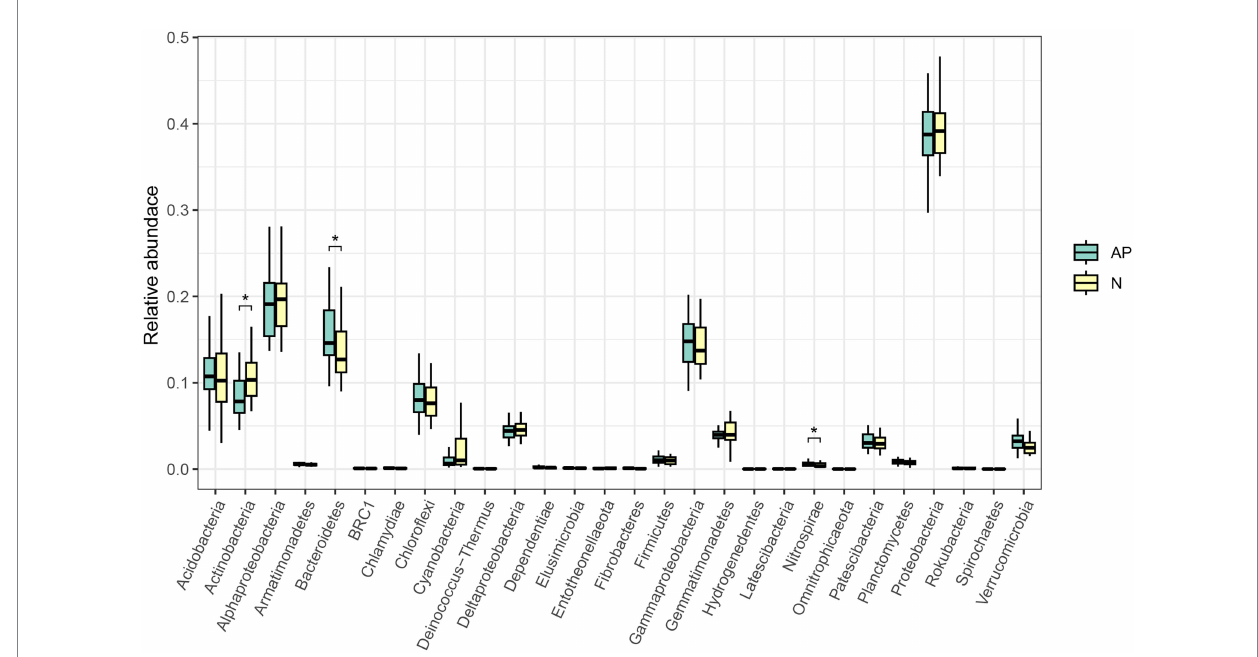
FIGURE 2 Kruskal-Wallis test at the phylum level of A . palmeri (AP) and native (N) rhizosphere soils. Significant level: * p <